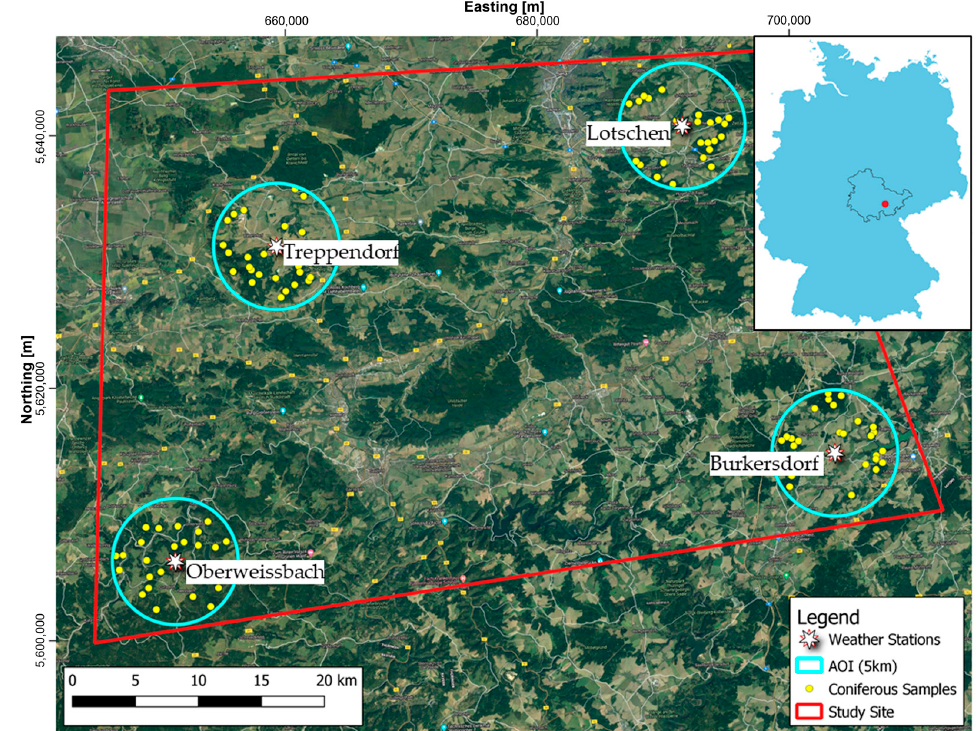
Figure 1. Overview of the study site (red), the areas of interest (AOI, blue circles), the coniferous sampling sites (yellow dots) and the weather stations (white stars) located in southeast Thuringia in central Germany. Satellite imagery provided by GeoBasis DE/BKG through Google Earth ( © 2021 Google).